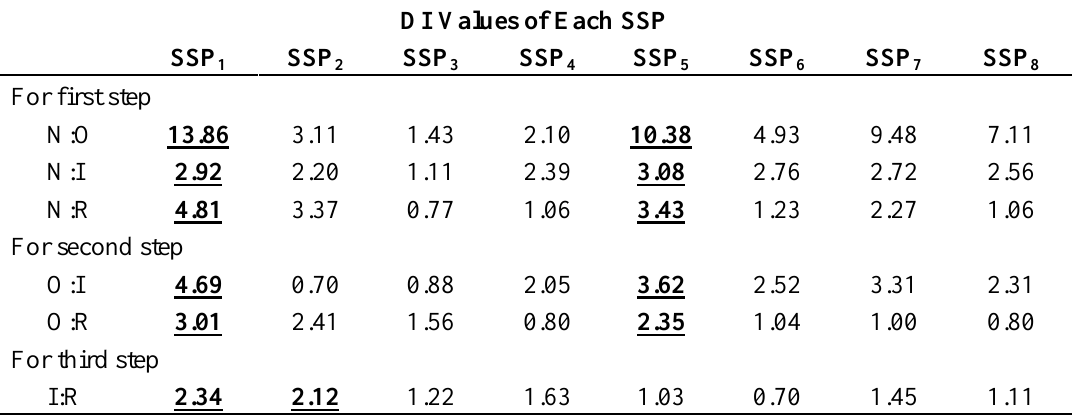
Table 5. DI values of SSPs for each sequential diagnosis